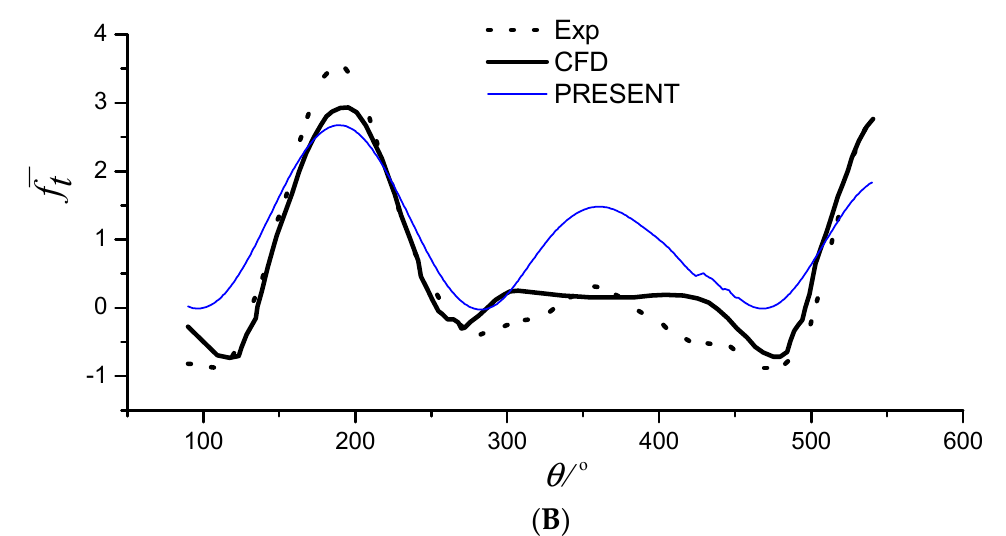
Figure 7. ( A ) Normal force coefficient ( λ = 5, Z = 2); ( B ) tangential force coefficient ( λ = 5, Z = 2).